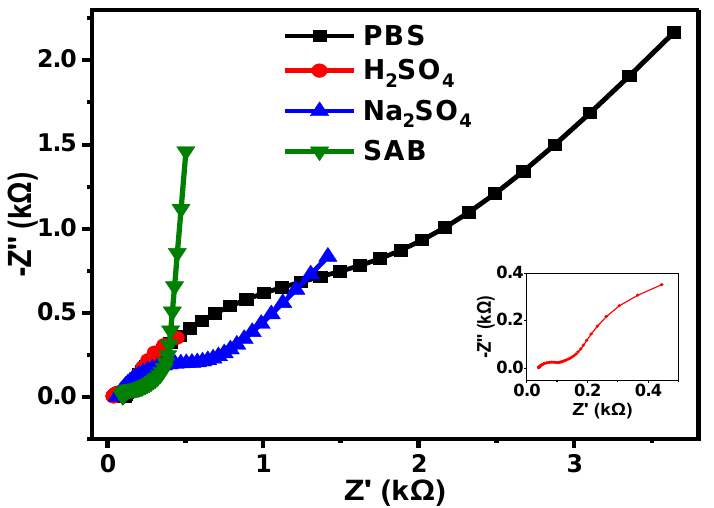
Figure 14. Nyquist plots of GCE-NiPcMWCNTs electrode in PBS, H 2 SO 4 , Na 2 SO 4 , and SAB electro- lytes.